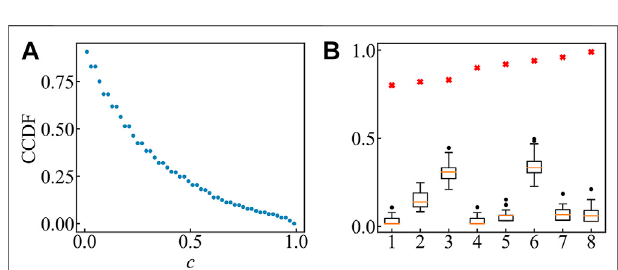
FIGURE3|(A) Complementary cumulativedistribution function(ccdf)of thesimilarityscores.Eachpointshowsthepercentageofscoresthataremore thanacertainvalue.Whenusingathresholdthatisnolessthan0.8,morethan 90% of the edges will be removed. (B) Boxplot of randomly shuf fl ed alarm sequences. For every chosen pair of devices, shuf fl e their sequence for 100 times and calculate the similarity scores of them. Red crosses symbolize the original similarity score. The original scores are completely separated from the shuf fl ed sequences scores ’ boxplots.